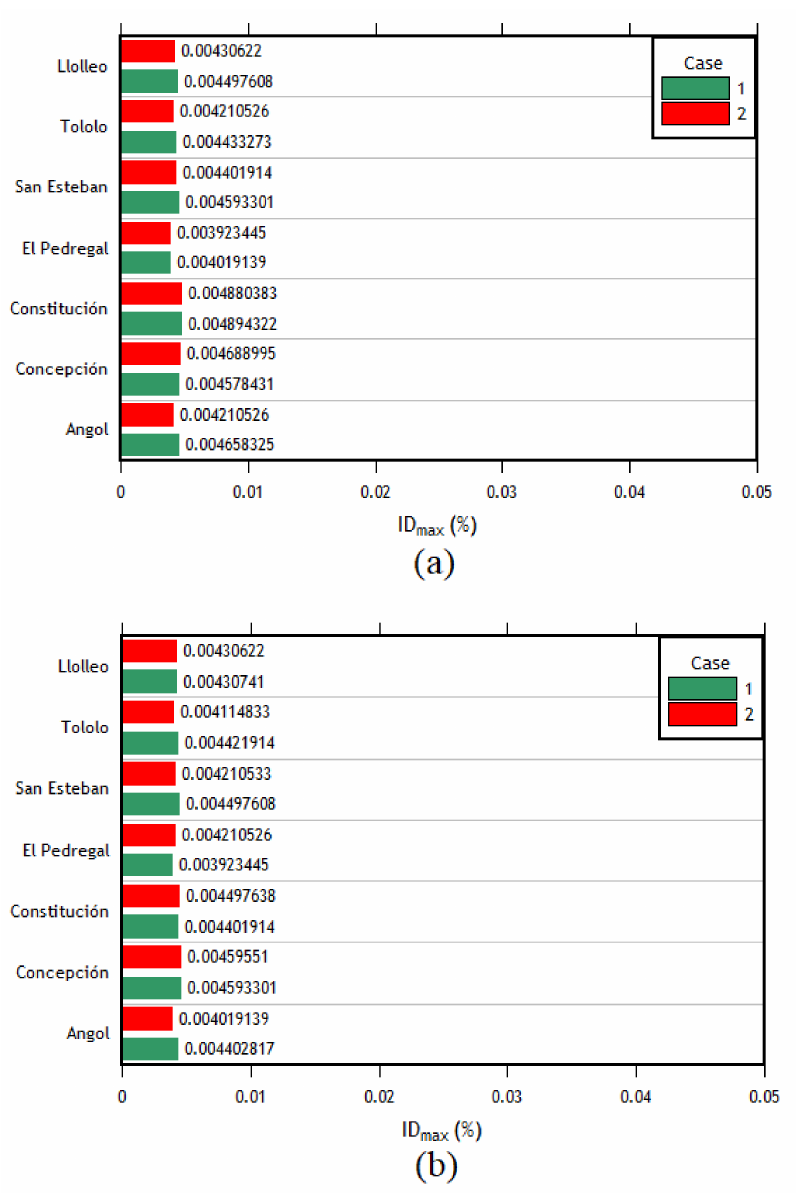
Figure 14. ( a ) Interstory drifts of the left central column of the external frames, cases 1 and 2 in the longitudinal direction; ( b ) Interstory drifts of the right central column of the external frames, cases 1 and 2 in the longitudinal